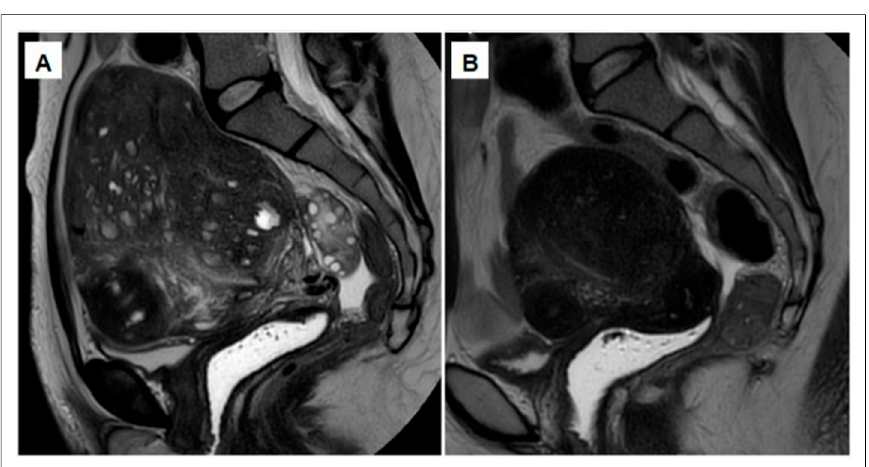
Figure 4. ( A ) MRI showing a very large uterus, consistent with severe full-thickness adenomyosis. ( B ) After a 12-week course of GnRH antagonist (daily dose of 200 mg linzagolix), a significant re- duction is observed in both uterine size and adenomyotic foci (adapted from